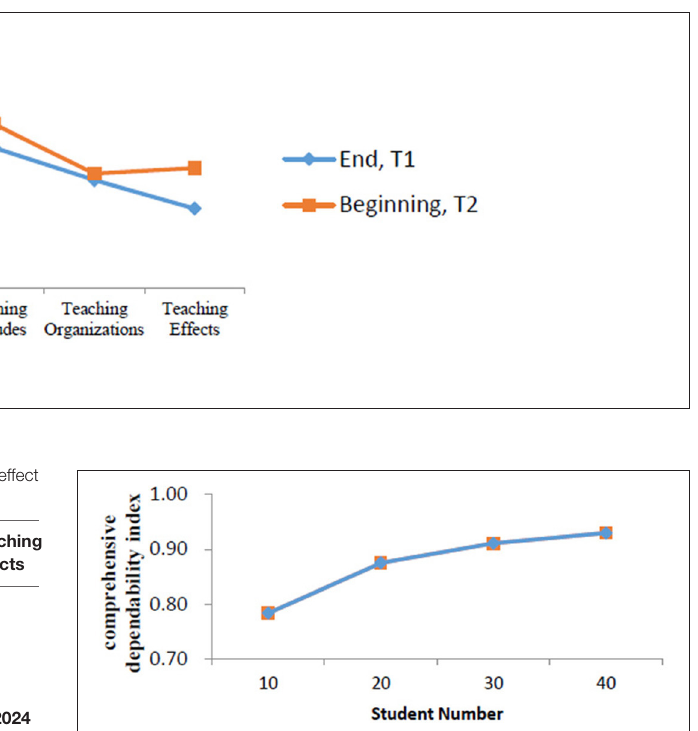
FIGURE 2 | Comprehensive dependability index for different student